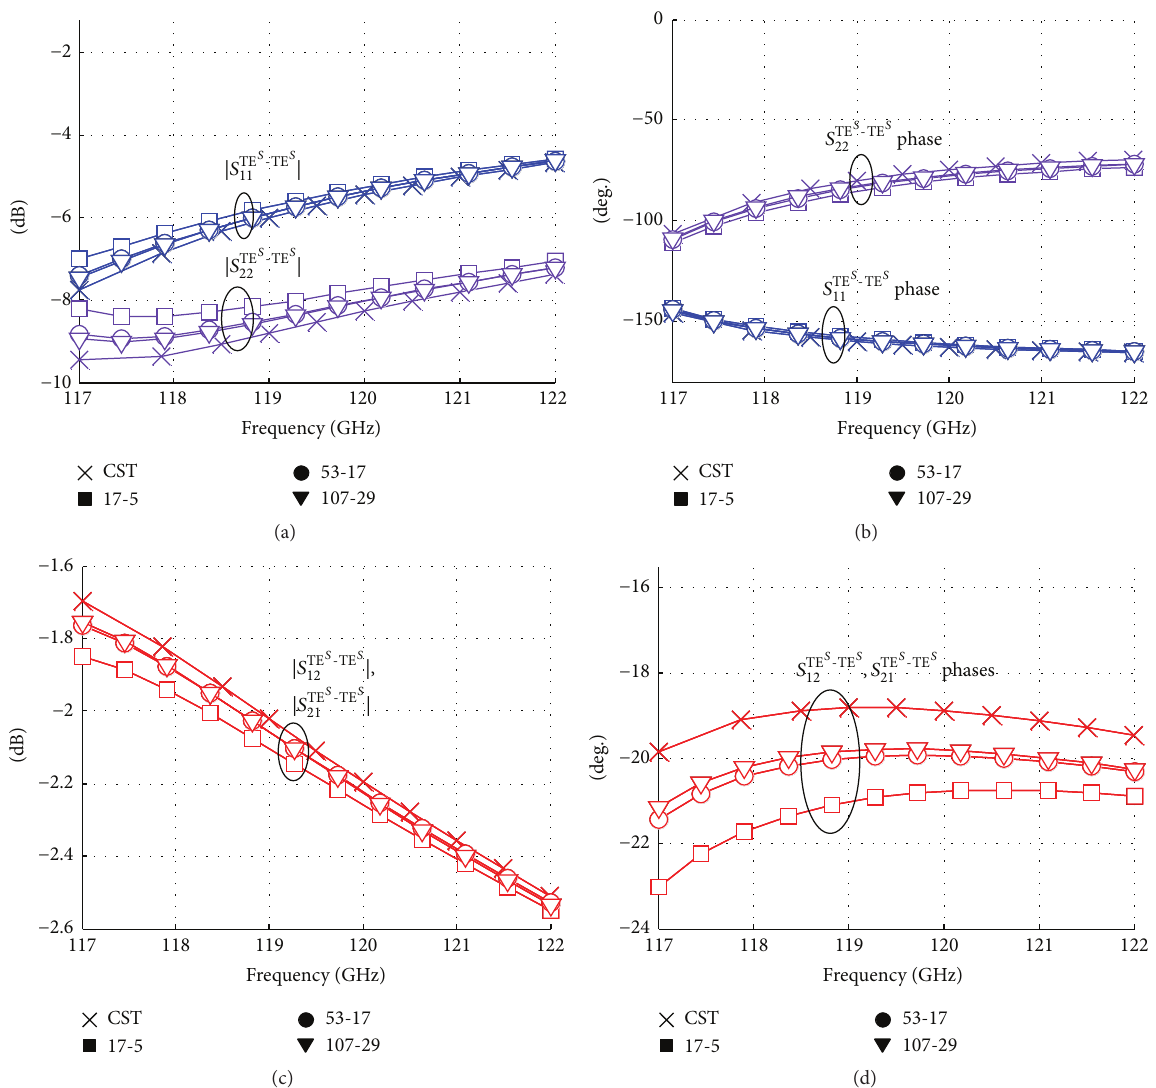
Figure8:Casestudya:modeTE 𝑆 10 inwaveguide 1 tomodeTE 𝑆 10 inwaveguide 2 :(a)reflectionmagnitude,(b)reflectionphase,(c)transmission magnitude, and (d) transmission